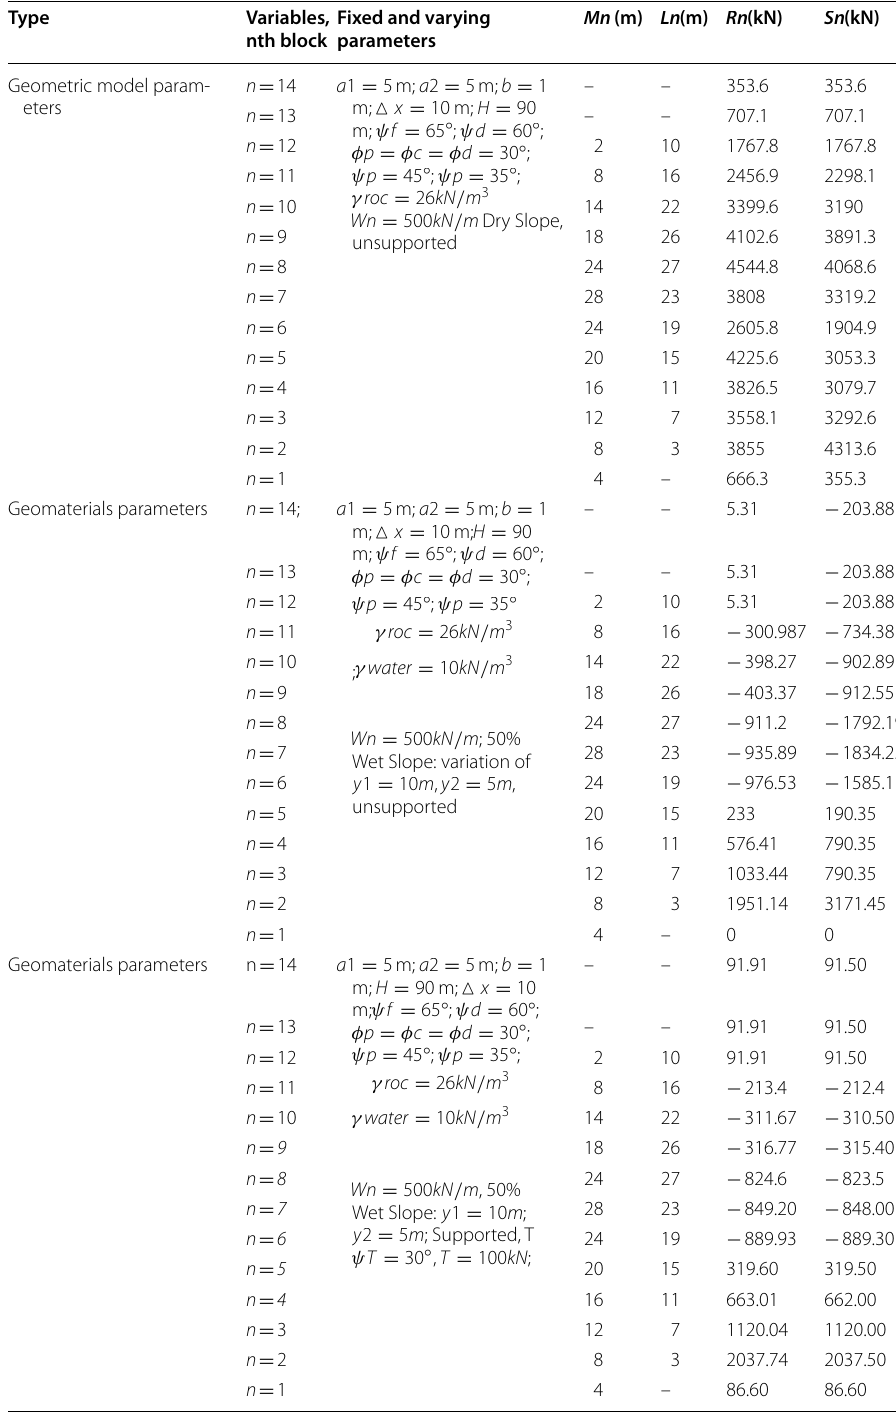
Table 5 Slope with varying